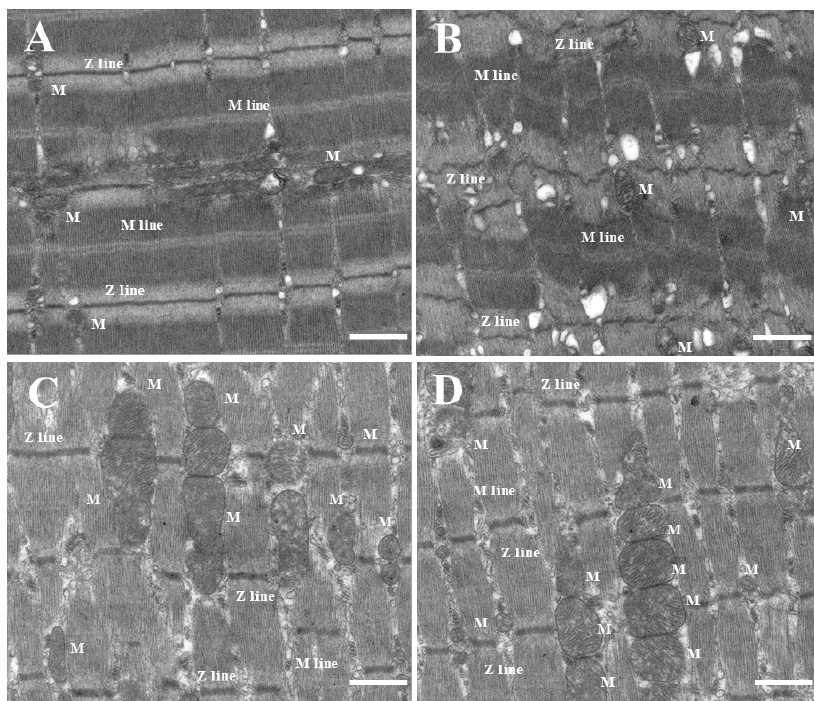
Figure 5. RSV-SLN alleviates the ultrastructural damage of skeletal muscles by excessive endurance exercise. Ultrastructure changes were shown via transmission electron microscopy from four groups of mice. Mt indicates mitochondria. The scale bars represent 500 nm in skeletal muscle tissues.